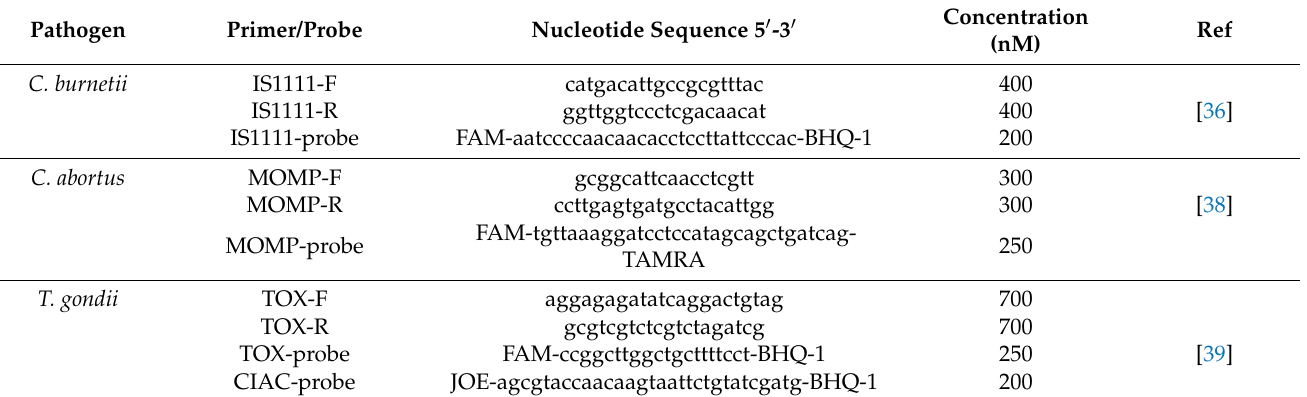
Table 1. Sequences and concentrations of oligonucleotide primers and probes used in this study.